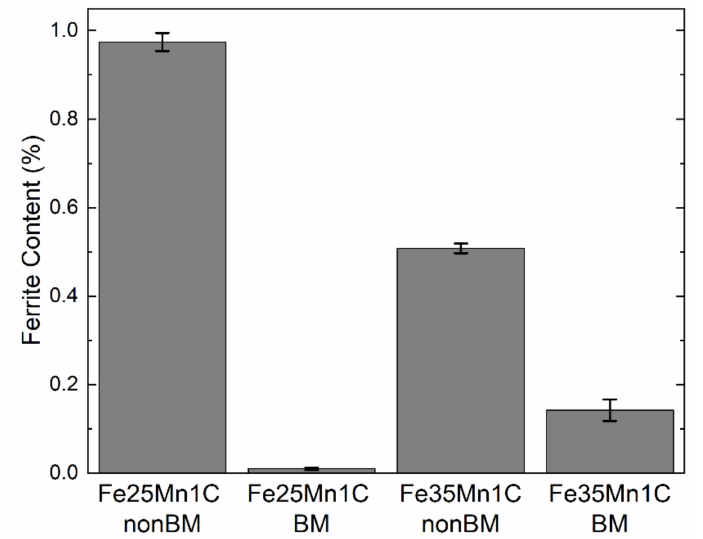
Figure 3. Relative phase content measured by